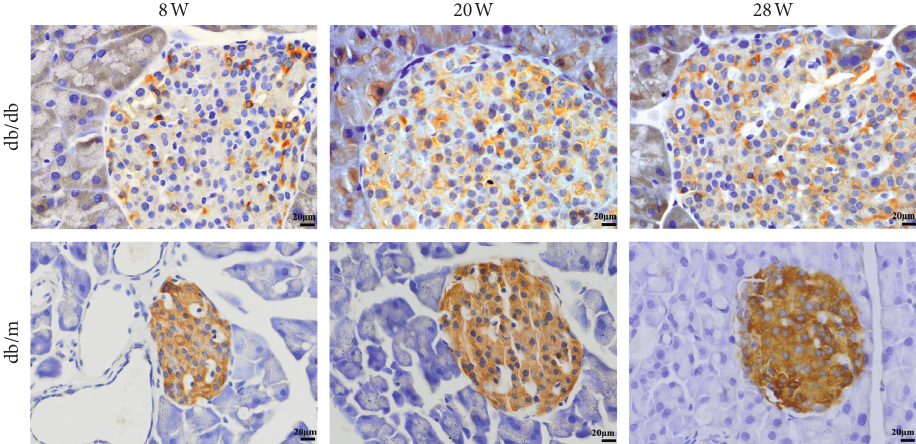
Figure 3: Expression of Wnt5a in the pancreas. Paraffin-embedded sections of db/m and db/db mouse pancreases showing the expression of Wnt5a as determined by immunohistochemistry (scale bar � 50 μ m).